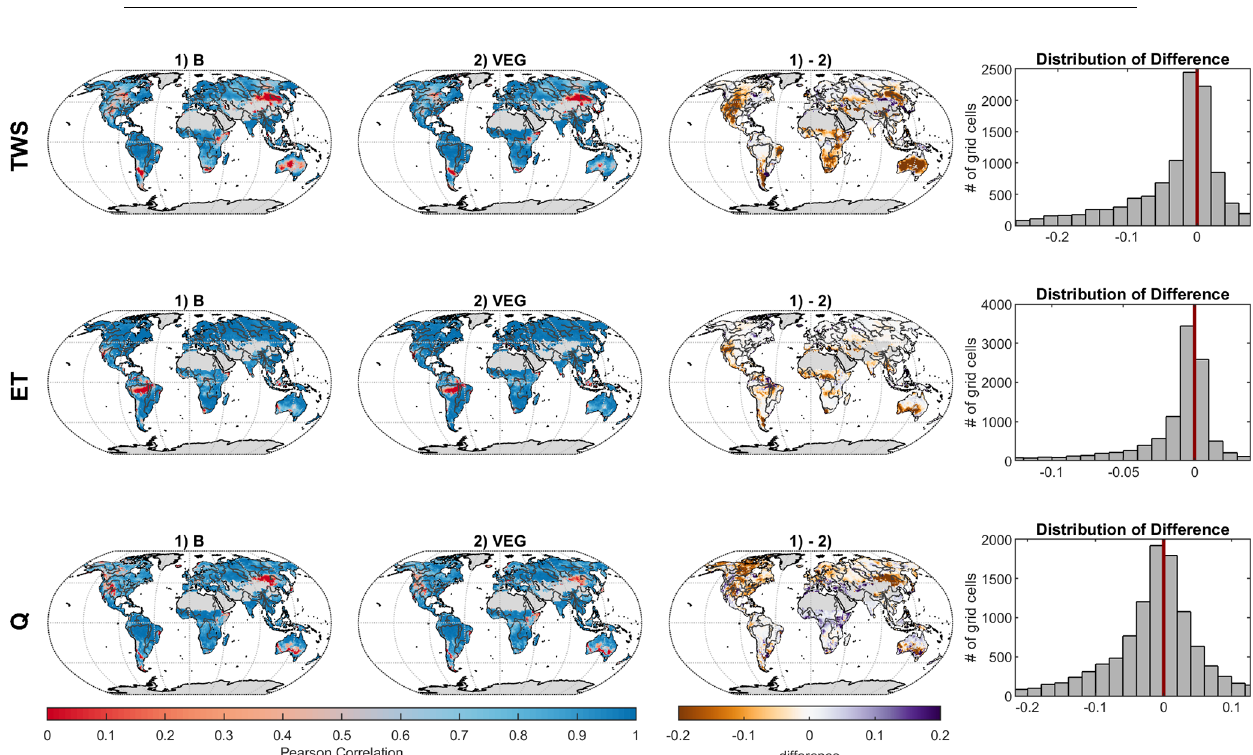
Figure 4. Grid-wise Pearson’s correlation coefficient for total water storage (TWS), evapotranspiration (ET), and runoff ( Q ) between (1) observations and B and (2) observations and VEG, as well as differences between (1) and (2) (brown colour, i.e. negative values, indicates higher correlations for VEG, while purple colour, i.e. positive values, indicates better correlation values for